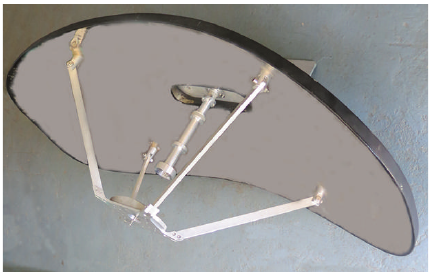
Figure 7: Photograph of ring-focus elliptical beam antenna.